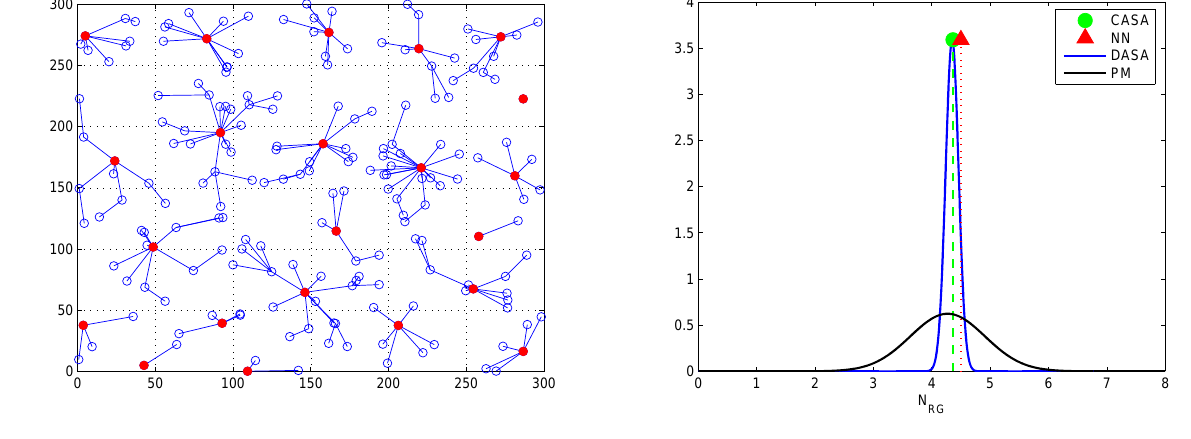
applying the proposed RG = 200 . s